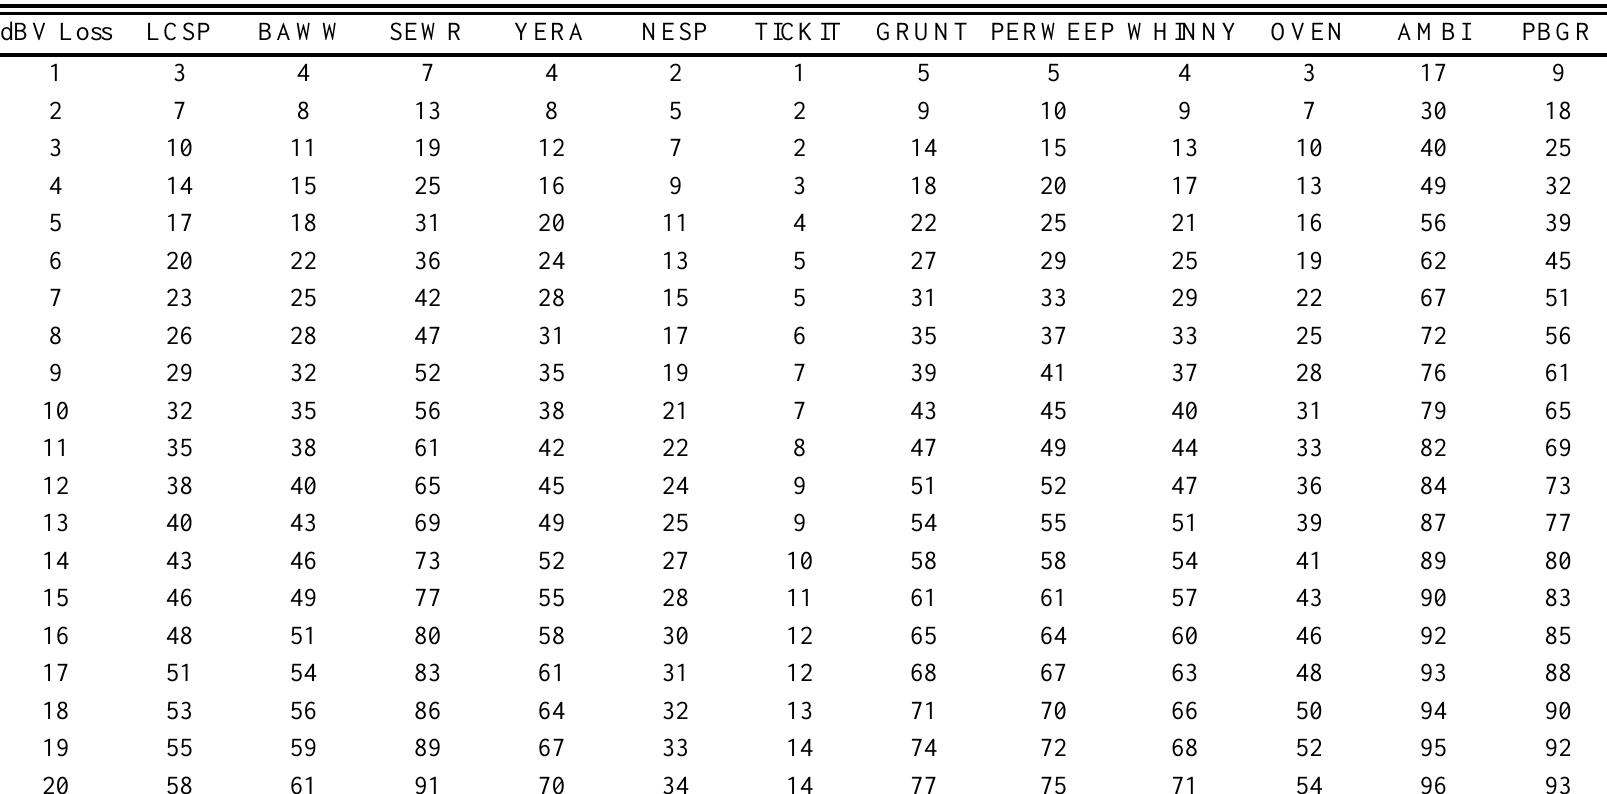
Table A5.6. Percent effective detection area loss of 12 call types for varying degrees of microphone sensitivity loss under 50 dBA noise